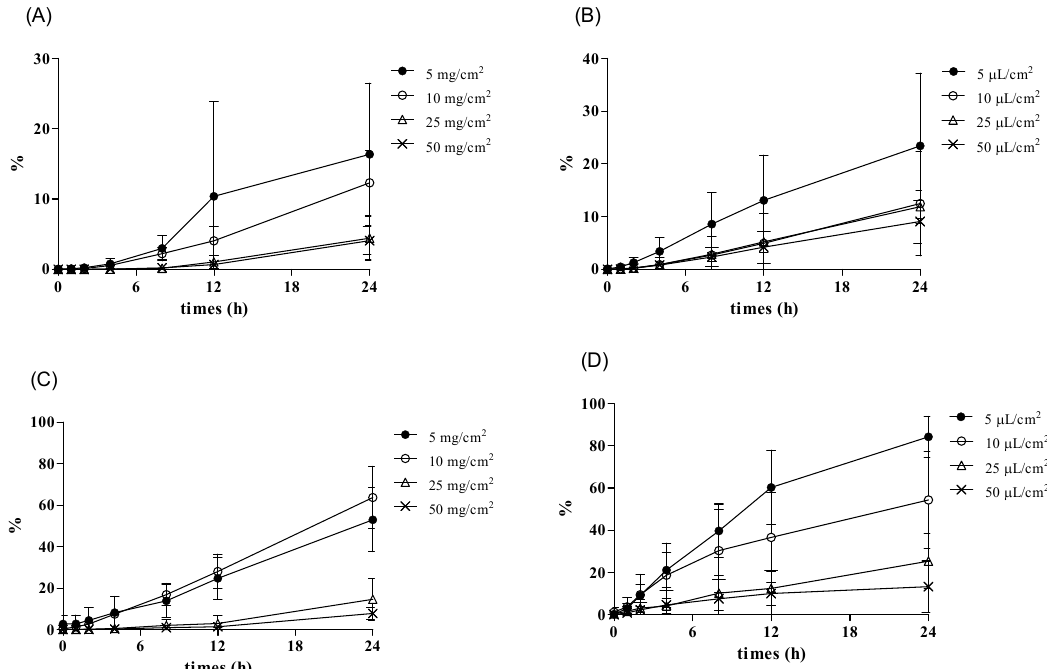
Figure 6. Penetration of caffeine (5, 10, 25, 50 mg or µL/cm 2 ) (mean ± SD). ( A ) Rat (cream), ( B ) rat (solution), ( C ) Micropig ® (cream), and ( D ) Micropig ® (solution).